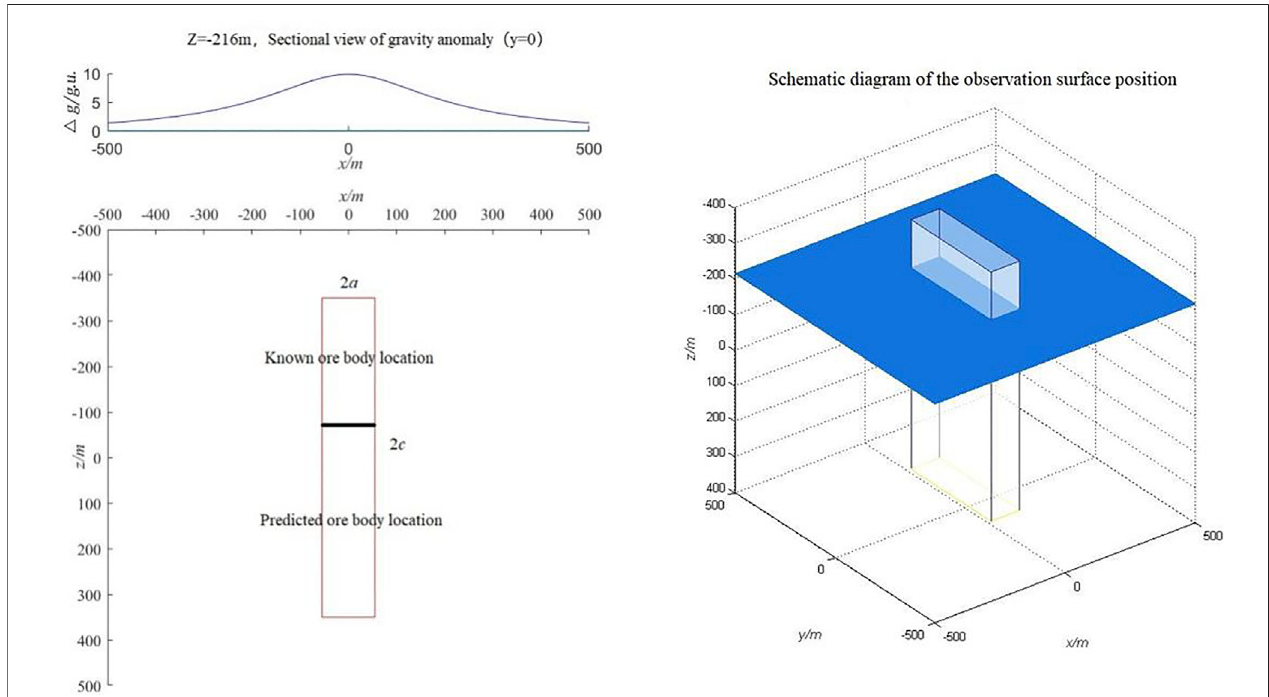
FIGURE 9 | Screenshot of the inversion procedure of the fi tting